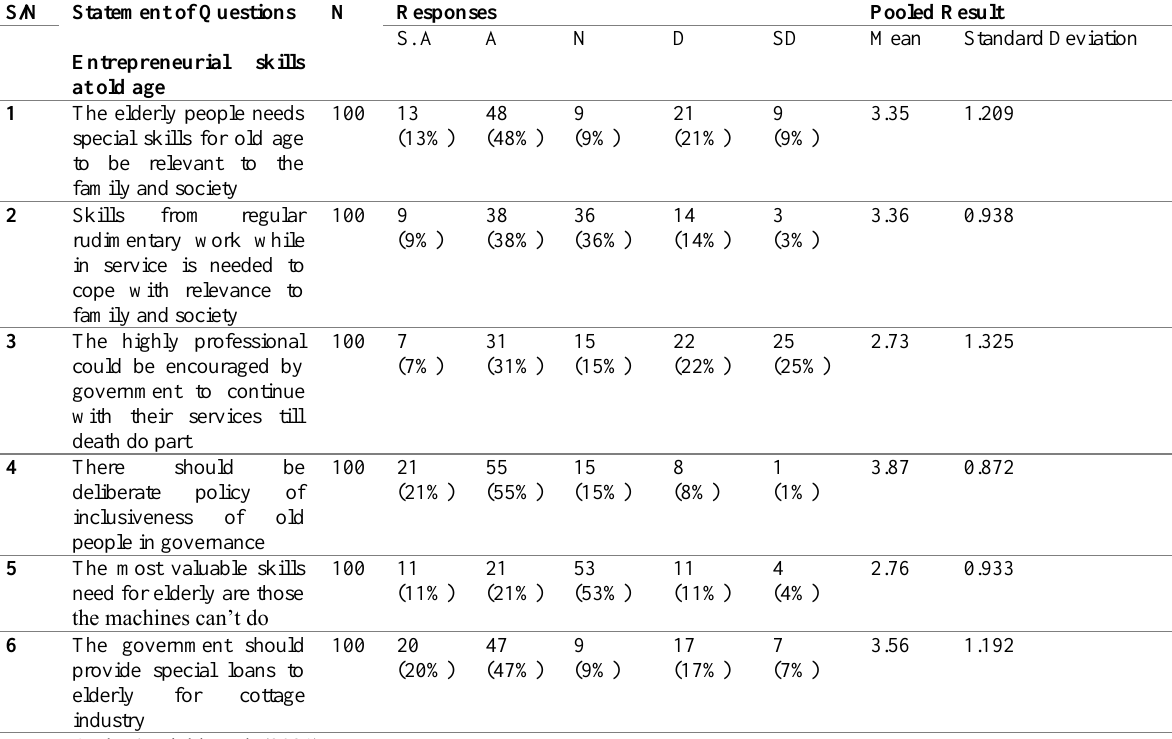
Table 4: Entrepreneurial skills at old age